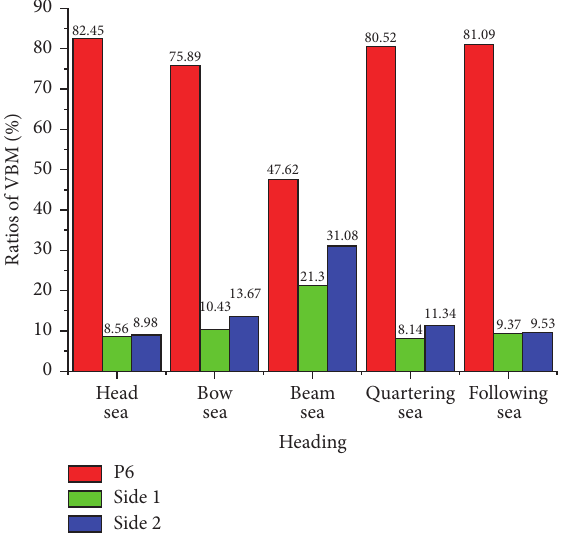
Figure 26: Ratios of VBM on main hull and side